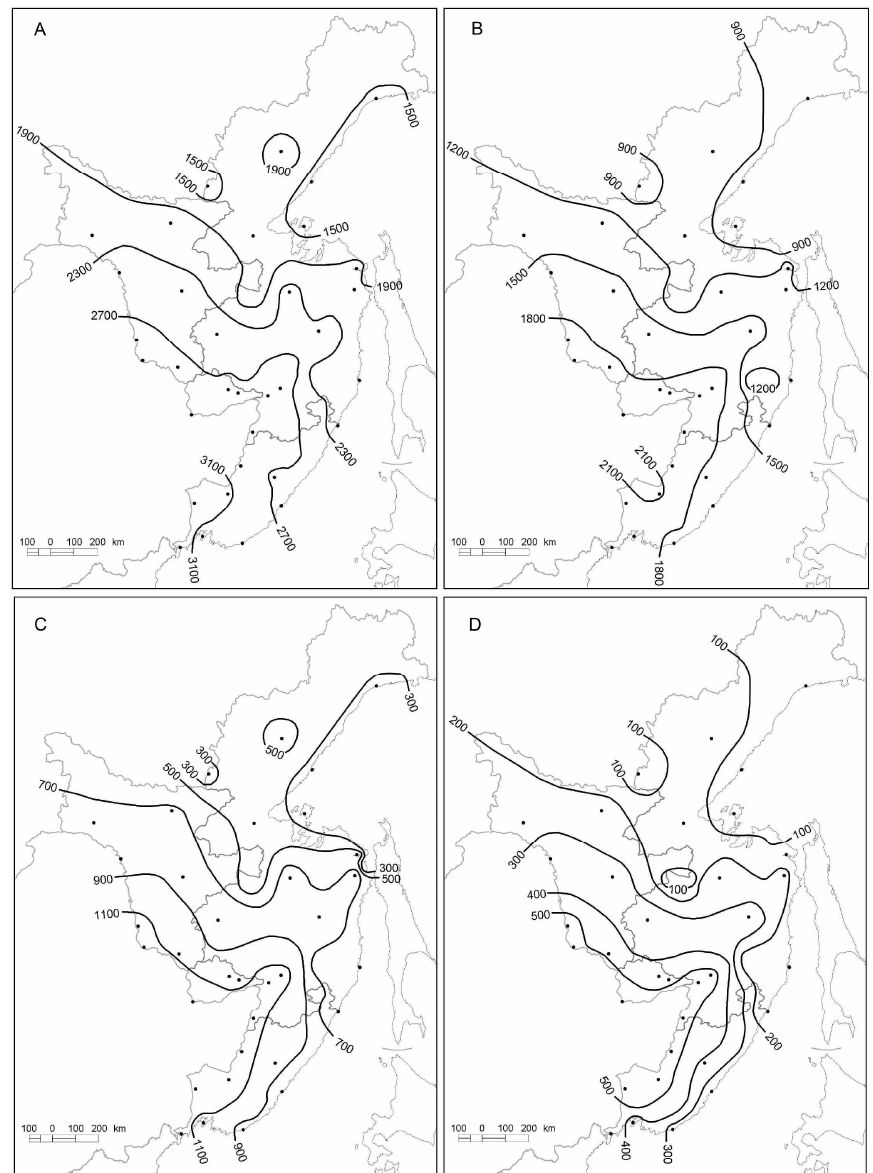
Figure 2. Growing degree days (GDD) in the Russian Far East for period 1966–2017 for four thresholds: ( A ) GDD0, ( B ) GDD5, ( C ) GDD10, and ( D ) GDD15.